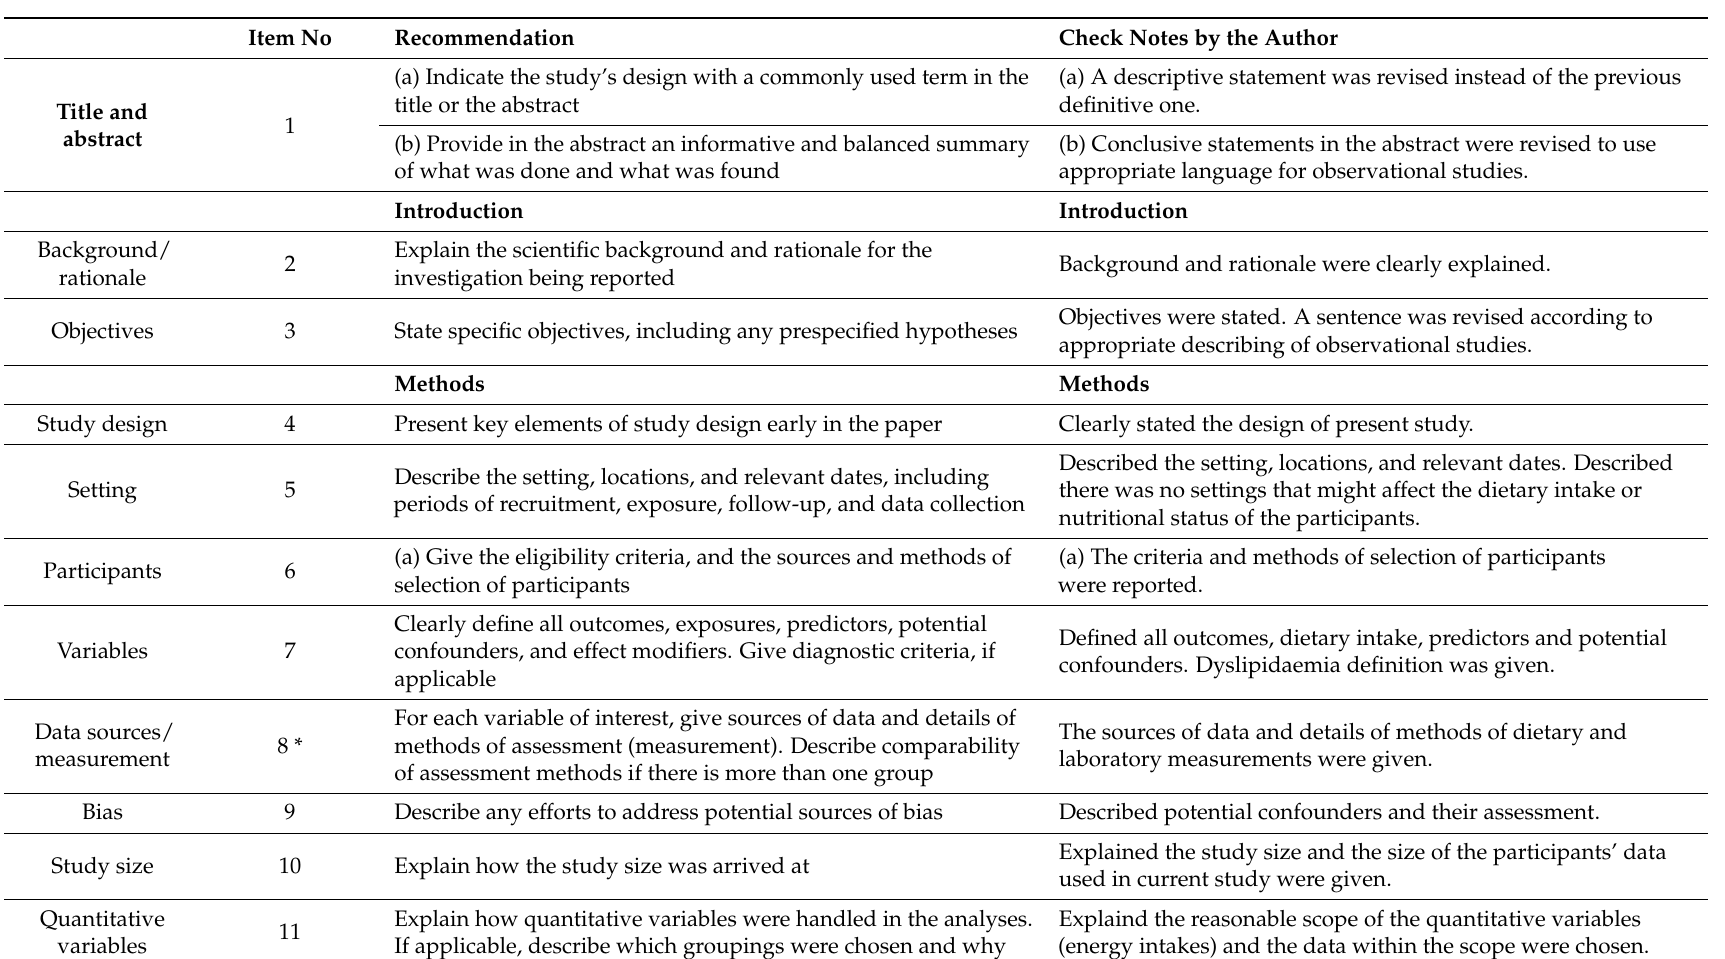
Table A1. STROBE Checklist—cross-sectional